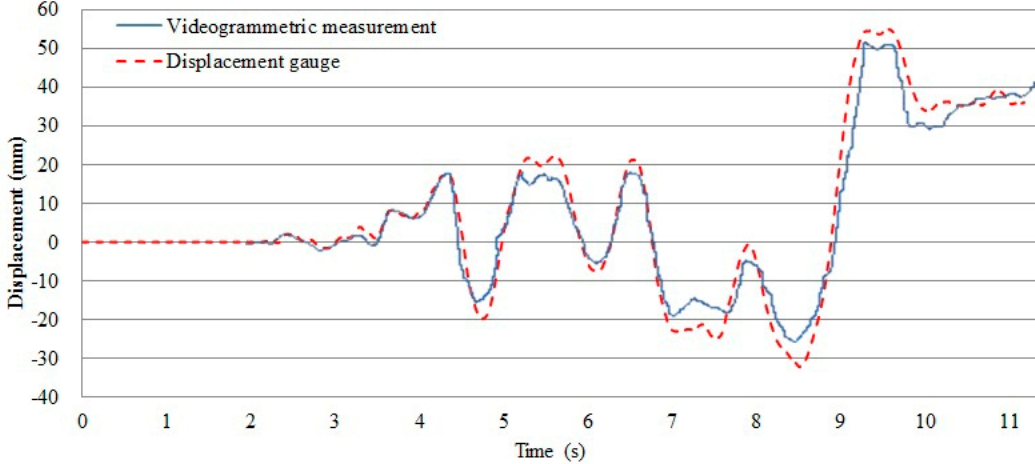
Figure 13. A displacement comparison between the proposed videogrammetric measurement method in the X direction and the traditional displacement gauge measuring method.